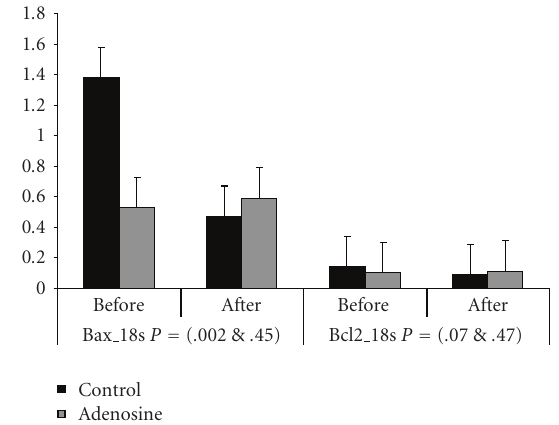
Figure 1: Baseline versus the postoperative expressions of bax and bcl2 in adenosine treated and the control groups. Gene expression is normalized to the same endogenous gene. Before and After refer to the timing of taking the biopsies (Before; before cross clamp application and After; after cross clamp removal and just before CPB